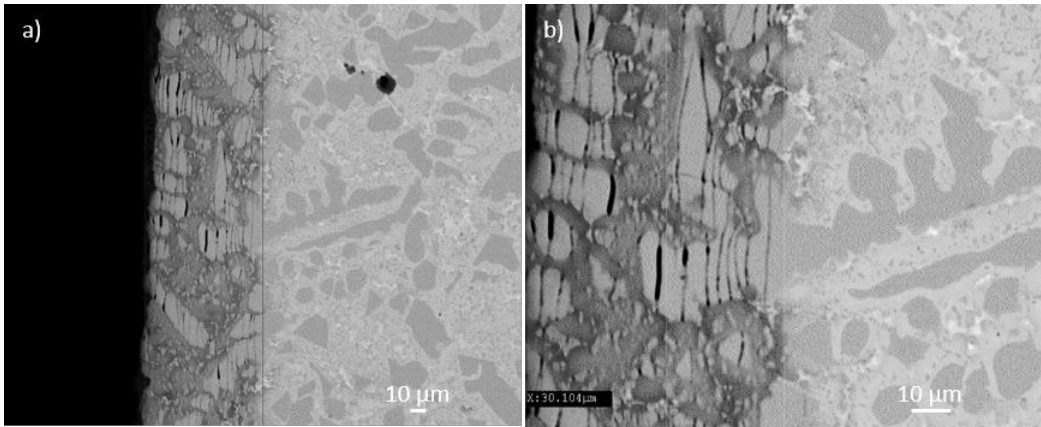
Figure 4. BSE image of cross sections of the alloy NbSiTiHf-5Al-5Cr after isothermal oxidation at 800 °C showing cracks in the diffusion zone. ( a ) overview, ( b ) detailed view.